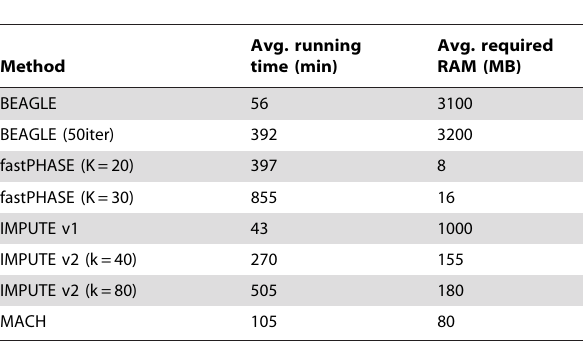
Table 1. Running times and memory requirements for various algorithms in Scenario